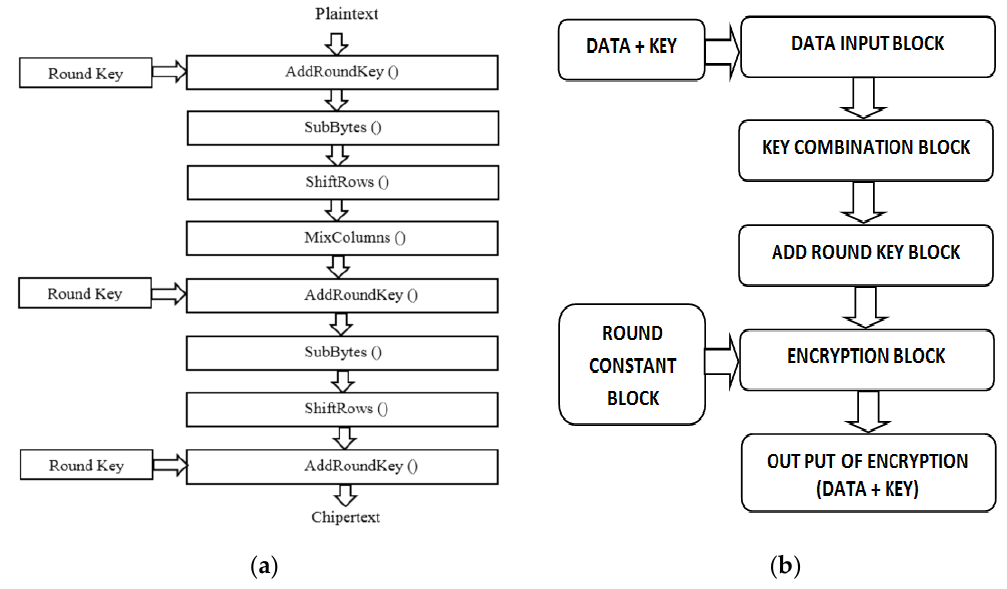
Figure 4. AES encryption round operations ( a ); process flow of the triple-keys AES algorithm proposed in ref. [23] ( b ).